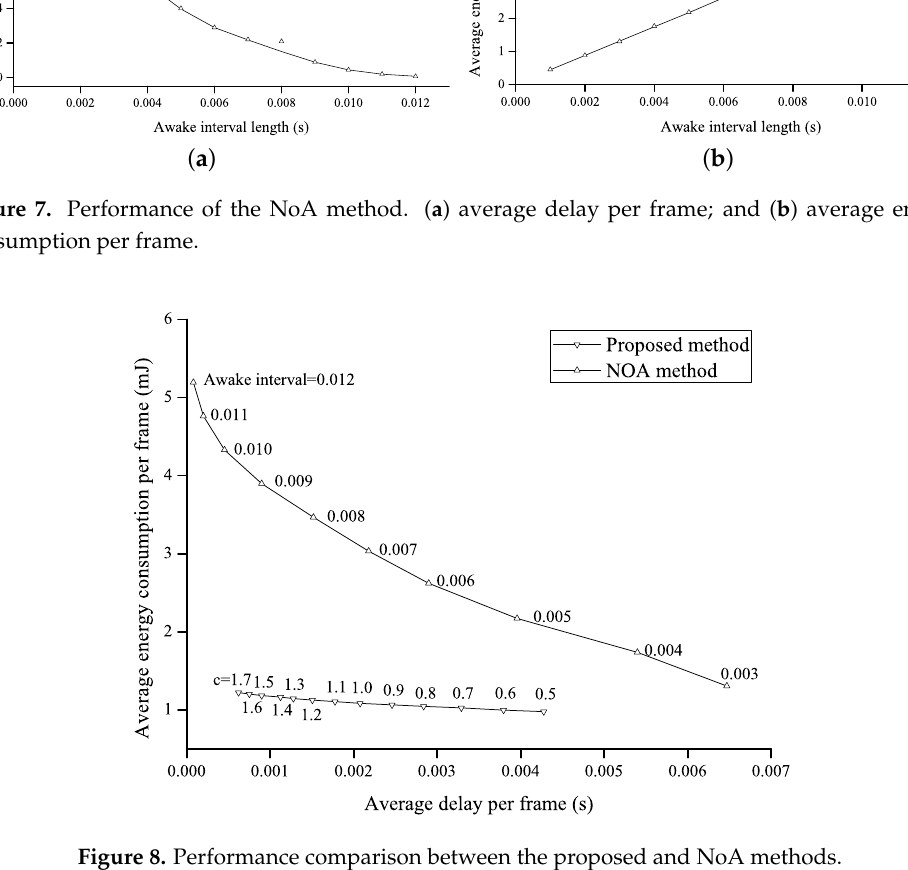
Figure 8. Performance comparison between the proposed and NoA